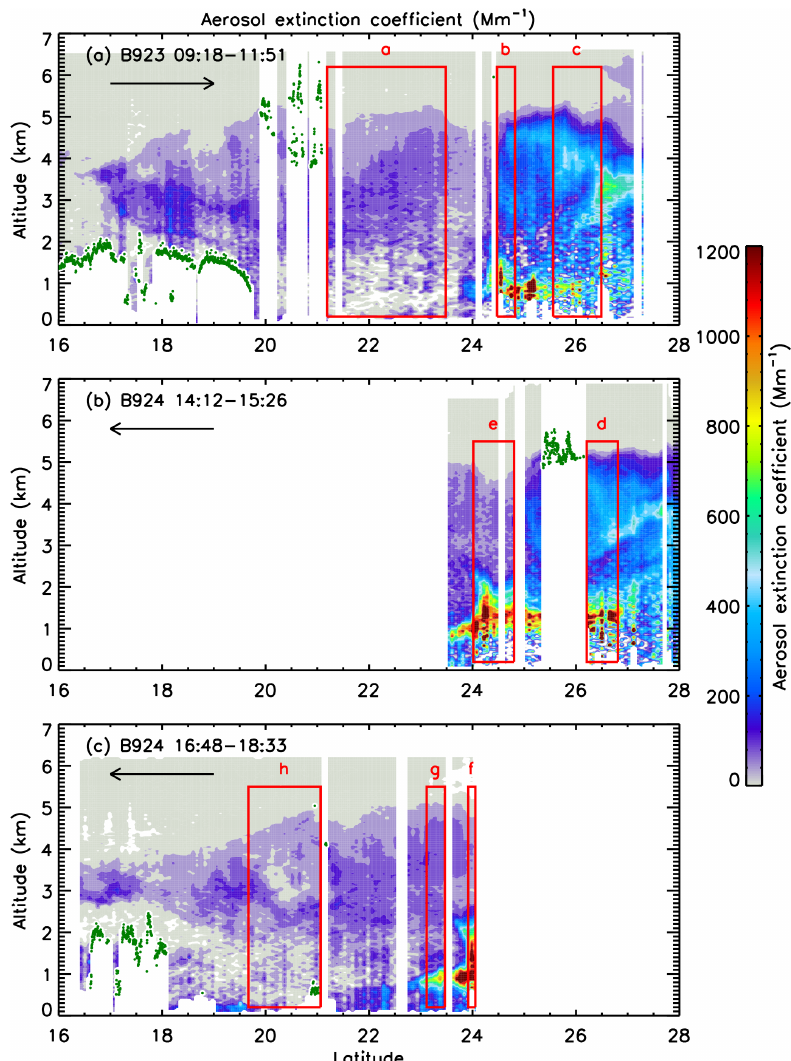
Figure 4. Bi-dimensional structure of the atmosphere on 12 August, for the high-altitude transects: (a) flight B923 from 15 to 28.5 ◦ N; (b) first part of B924, from 28.5 to 23.5 ◦ N; second part of B924, from 24 to 15 ◦ N. This curtain plot is coloured according to the aerosol extinction coefficient measured by lidar at 1min integration time ( ∼ 9km footprint). The green dots indicate cloud tops detected with the lidar at 2s integration time ( ∼ 300m horizontal resolution). The red boxes and letters identify the transect portions that have been used to derive the profiles displayed in Fig. 1. The arrows indicate the direction of travel of the